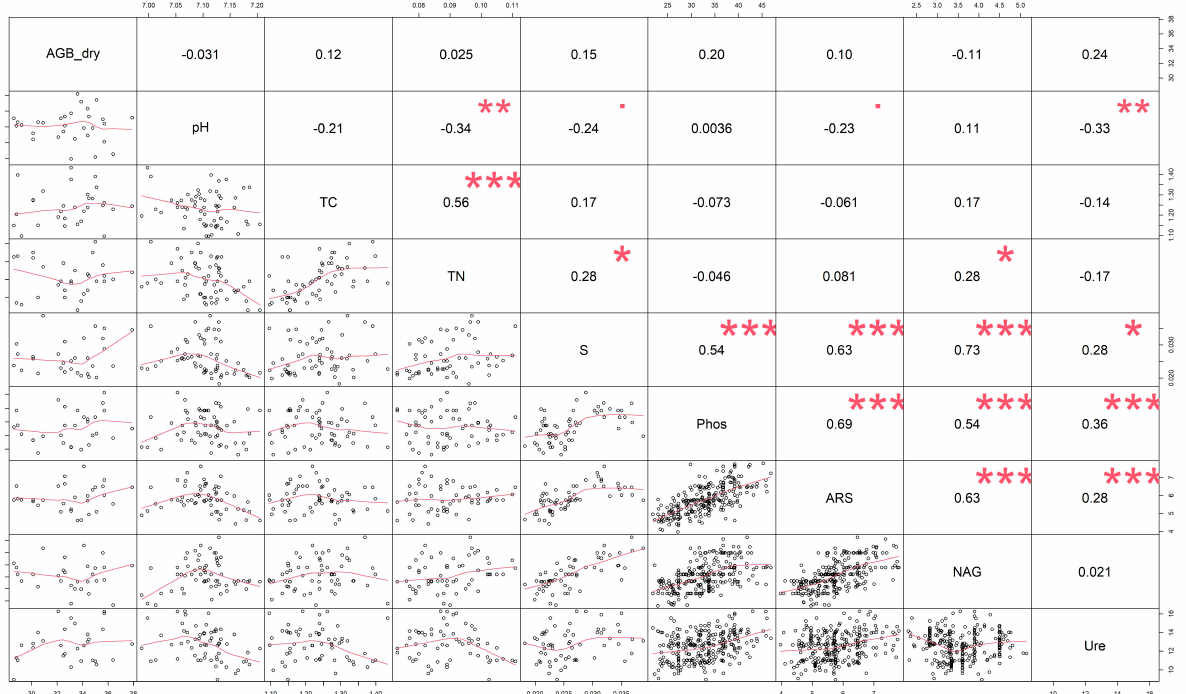
Figure A2. Results of Pearson’s correlation analysis in the main cultivation of maize in the pot experiment. The symbols indicate differences between the variables at the following levels of statistical significance: ˙ p ≤ 0.1, * p ≤ 0.05, ** p ≤ 0.01, *** p ≤ 0.001.